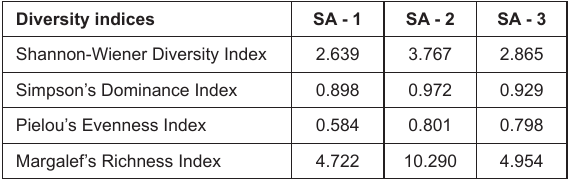
Table 1. Diversity indices for the three study areas (SA 1, 2 & 3) in and around Neora Valley National Park.